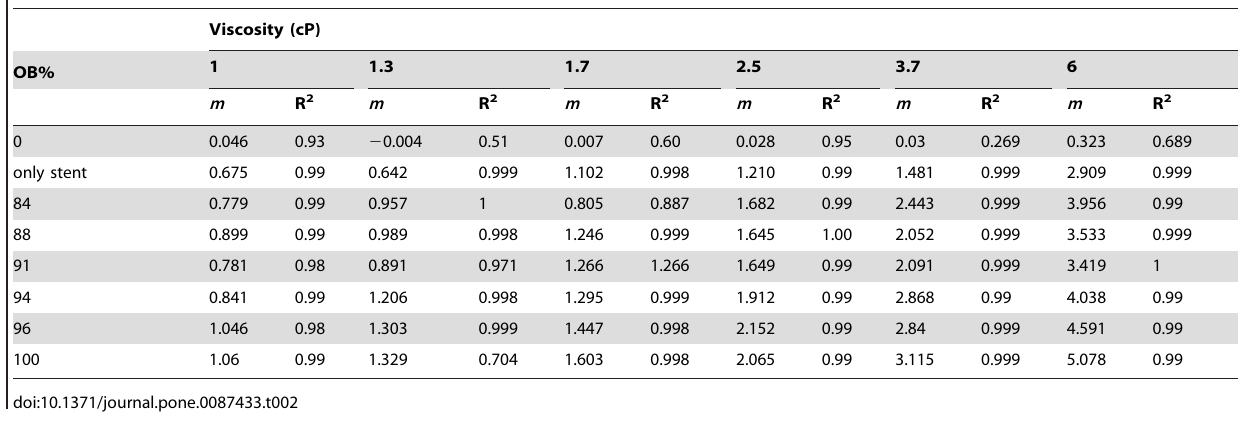
Table 2. Hydraulic resistances (in cmH 2 O*60 s/ml) measured from the slope ( m ) of the linear regression (R-squared values, R 2 , are also reported) of renal pelvic pressure versus flow rate values (example in Figure 5A) for each combination of viscosity and severity of obstruction (OB%).